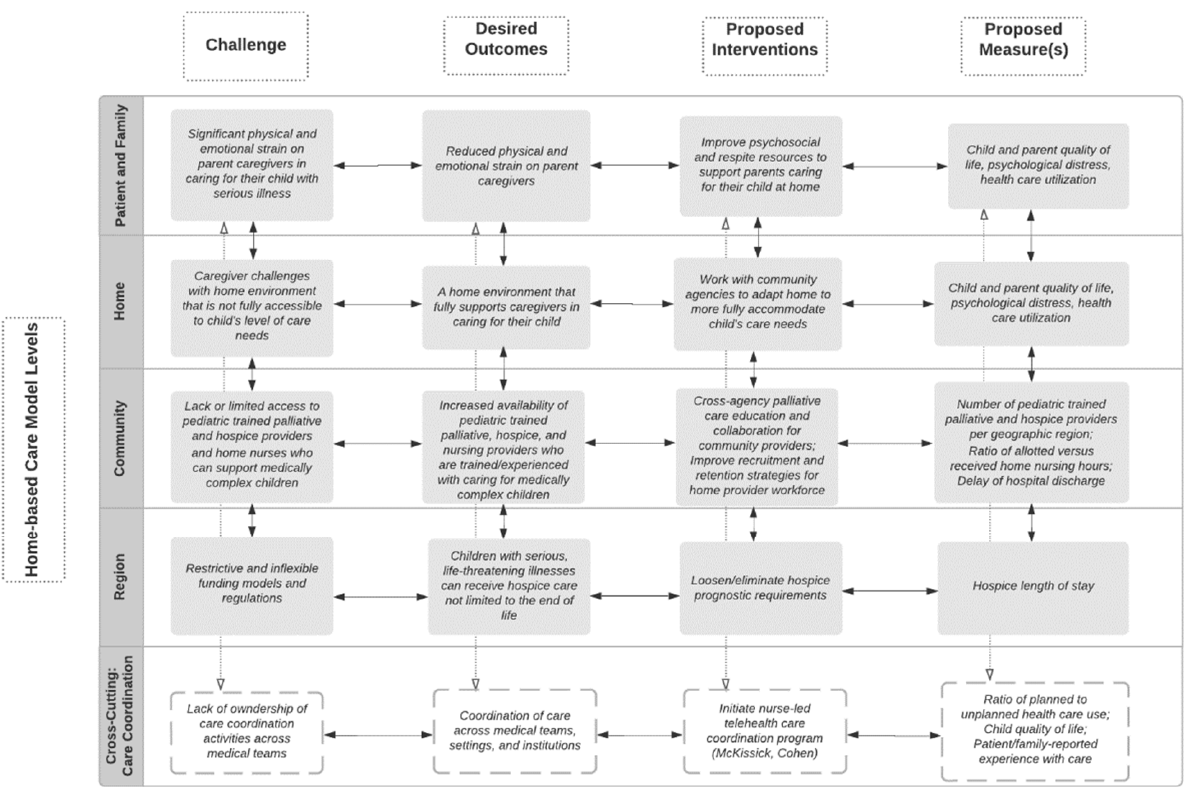
Figure 2. Example multilevel intervention model for home ‐ based care for children with serious illness and their families. This intervention model is derived from the proposed ecological framework (Figure 1). As can be seen, interventions should target all levels of the system of home ‐ based care, including improving the support and strengthening the capacity of family caregivers [31,145]; targeting the capacity of health systems to support children and families in the home through increasing education, training, recruitment, and retention of community ‐ based providers who care for children with serious illness; challenging the existing systems of regulation and financing of care (e.g., loosening or eliminating hospice prognostic requirements) [7,10]; improving care collaboration and coordination between community ‐ and hospital ‐ based institutions [7,28,67,146]; targeting care coordination to bridge interventions across levels. Desired outcomes, specific measures, and analytic strategies should be carefully matched to individual interventions, as well as across levels of intervention [142,143]. Created in Lucidchart (www.lucidchart.com accessed on 21 July 2022).